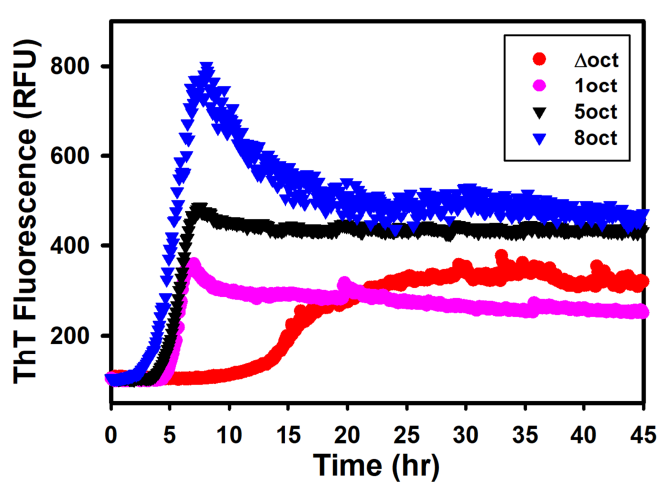
Figure 4. Kinetics of fibril conversion from four PrP variants.